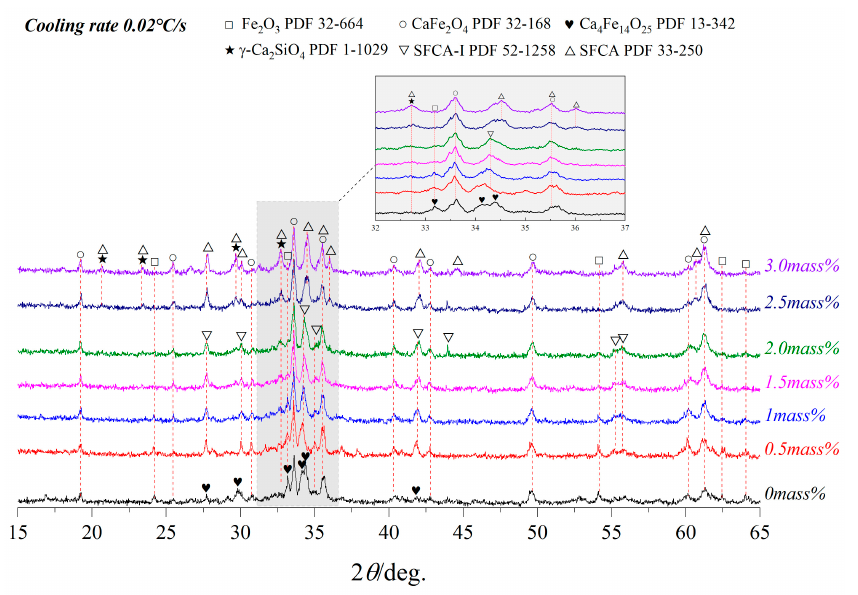
Figure 2. XRD patterns of samples cooled at 0.02 °C/s.